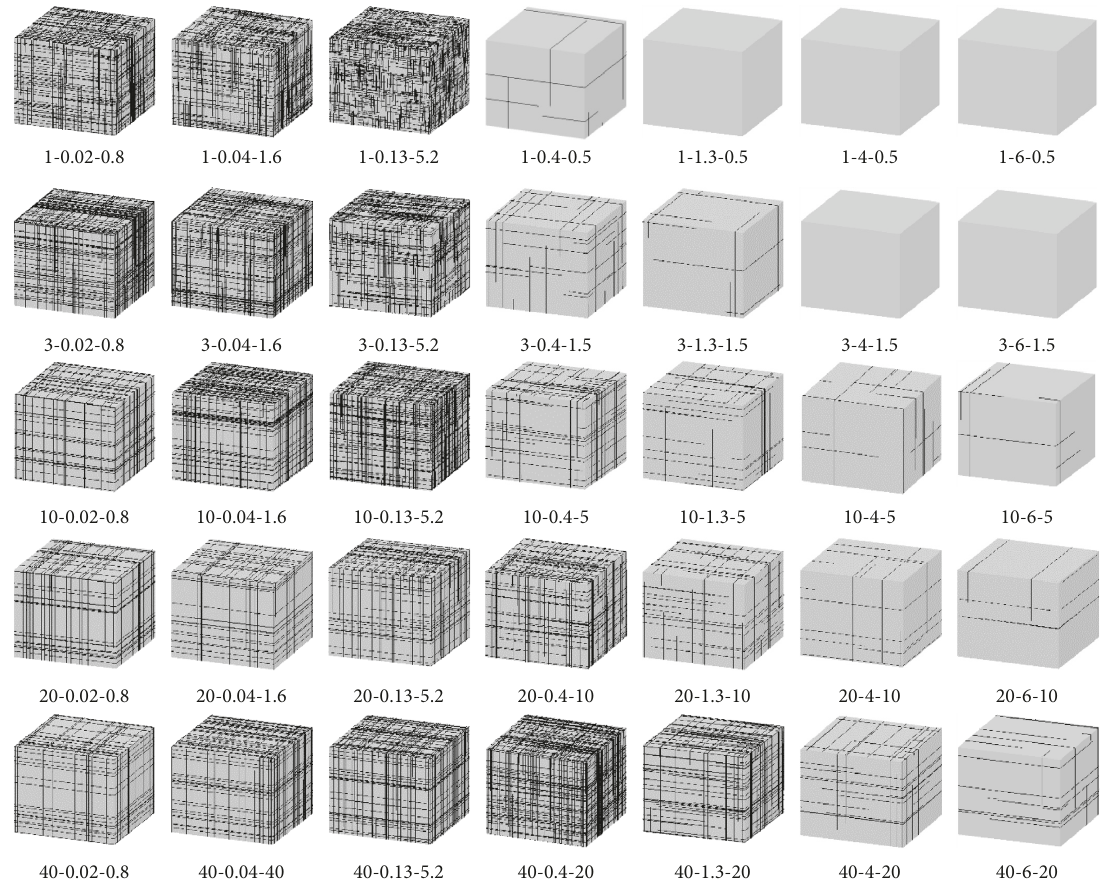
Figure 3: Thirty-five types of three-dimensional joint network models with different combinations of joint spacing and persistence. Each model’s number is stated below the model; the first number indicates joint persistence, the second indicates joint spacing, and the third represents the side length of the model. Table 4: MB i values (%) of the 35 types of hypothetical models and the corresponding